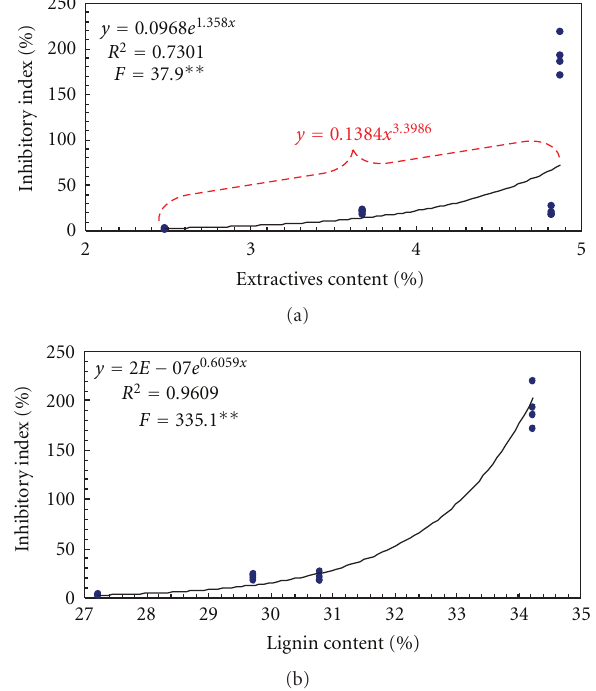
Figure 2: Relationship between extractive/lignin content and inhibitory index of coir fibres on cement setting. Note: ∗∗ statistically significant at α = 0 . 01 level.